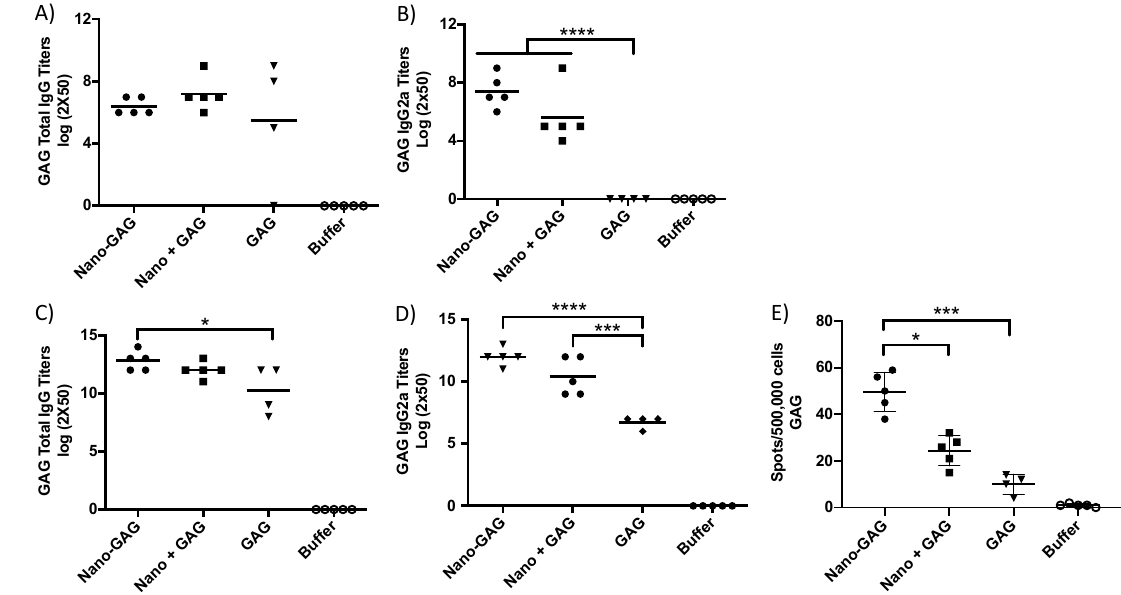
Figure 2. Coupling of the SIV GAG to the PapMV nanoparticle enhances the immune response directed to the GAG antigen. Balb/C mice, 5 per group, were immunized twice by the intramuscular route (i.m.) at a 21 day interval with, respectively, PapMV nano coupled to the Gag antigen (nano-GAG) (65 µg), PapMV nano (55.25 µg) mixed with GAG (9.75 µg) (Nano plus GAG), GAG alone (9.75 µg) and buffer control (10 mM Tris, 150 mM NaCL pH8). The assessment of the humoral response directed to the GAG recombinant antigen was performed with serum harvested at day 20 ( A , B ) or at day 33 ( C , D ). The anti-GAG total IgG ( A , C ) and IgG2a titers ( B , D ) were measured. The spleen was harvested at day 34 to perform the ELISPOT assay ( E ). The splenocytes were activated with the SIV GAG recombinant proteins. * p < 0.05, *** p < 0.001, **** p < 0.0001.